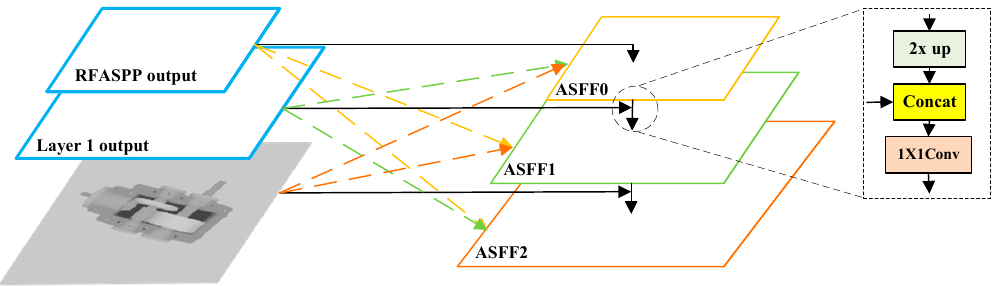
Figure 2. The adaptive spatial feature fusion module.